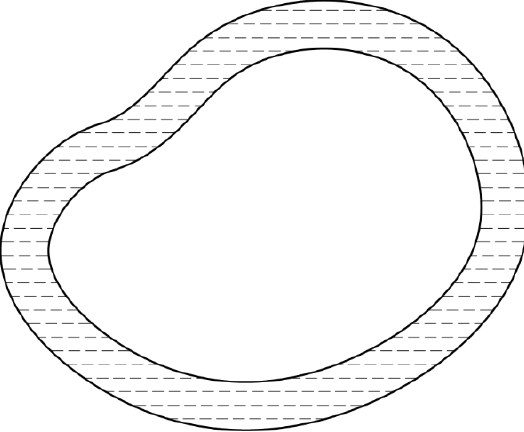
Figure 3. Example of cross section with cavity (linear paths in dotted